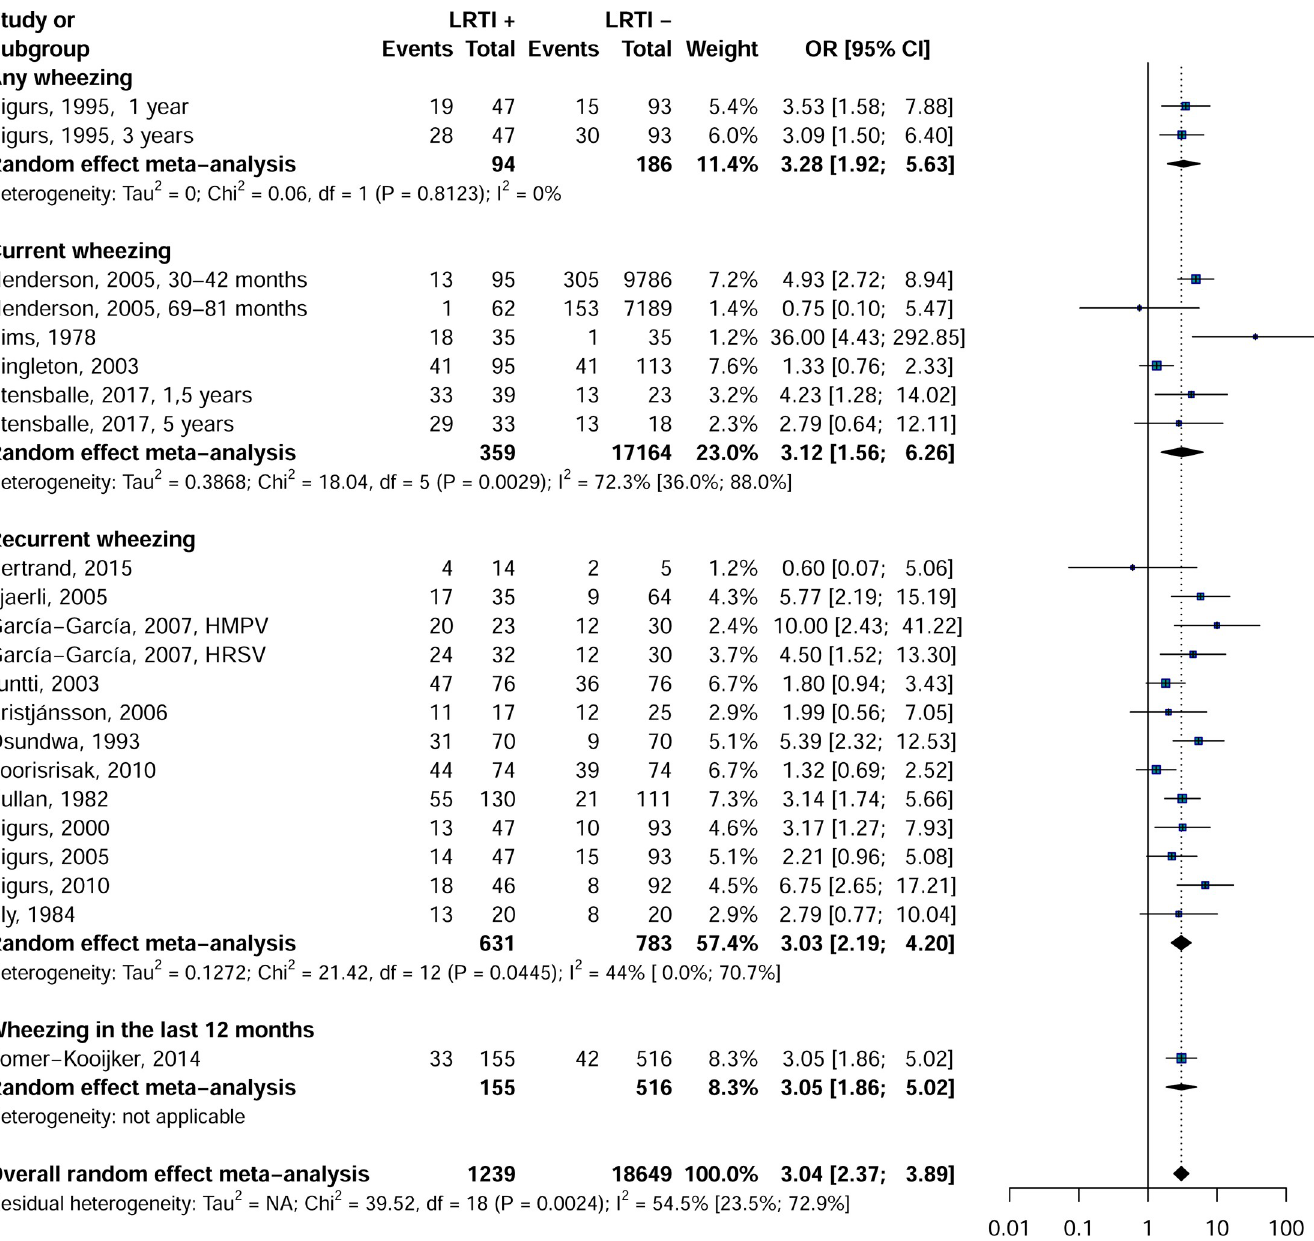
Fig 2. Forest plot of wheezing in children with and whitout LRTI in infancy.